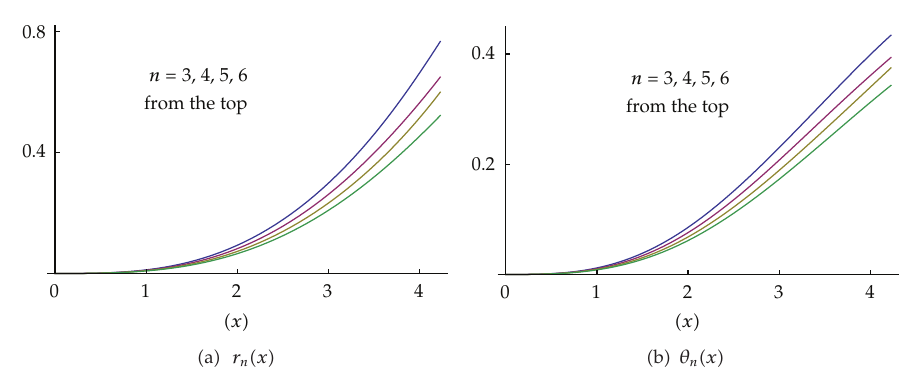
Figure 5: Graphs of the ratios r n (cid:3) x (cid:4) and the weight functions θ n (cid:3) x (cid:4) , n (cid:6) 3 , 4 , 5 , 6 (cid:3) β (cid:6) 0 (cid:4) . Table 1: Comparison of the L 2 -norm errors of the truncated Blasius series S n (cid:5) 1 (cid:3) x (cid:4) , the presented solution